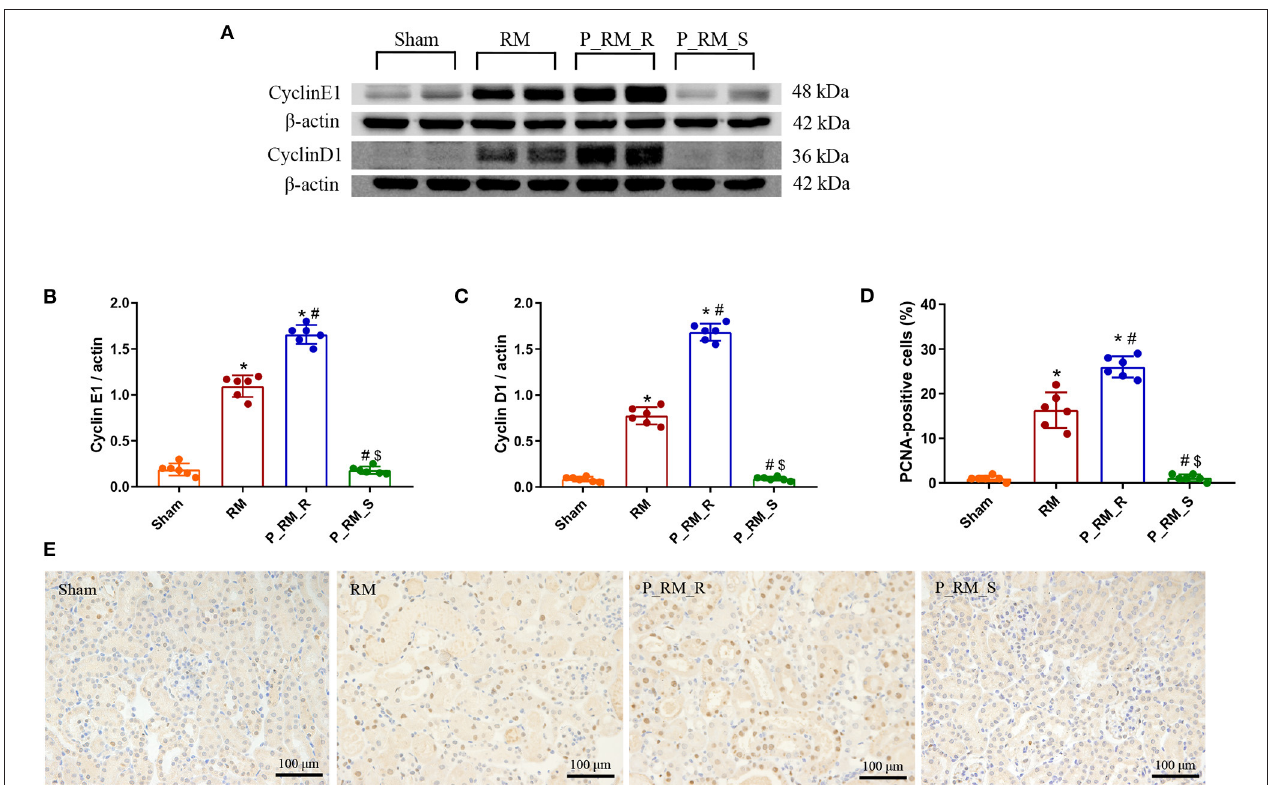
FIGURE 9 | Exogenous biological renal support promotes tubular cell proliferation in RM-induced AKI. (A) The levels of cyclin D1 and cyclin E1 were measured by Western blot analysis. (B,C) Quantitative analyses of the band densities (protein expression) of cyclin D1 and cyclin E1. (D) Percentage of PCNA-positive tubular cells. (E) PCNA staining. RM, rhabdomyolysis; P_RM_R, the mouse in the parabiosis model administered glycerol; P_RM_S, the other mouse in the parabiosis model supplying the exogenous biological renal support. * P < 0.05 vs. the sham group; # P < 0.05 vs. the RM group; $ P < 0.05 vs. the P_RM_R